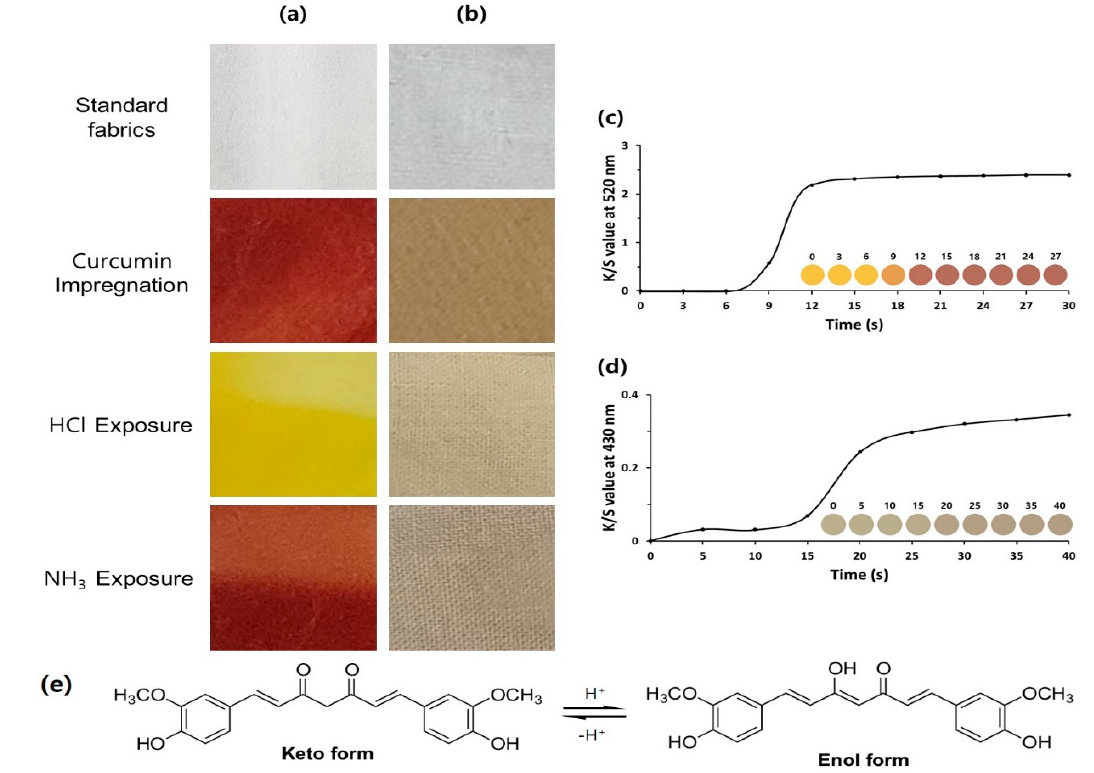
Figure 4. The photographs showing the color changes in ( a ) CECF and ( b ) dyed cotton samples; the traced K/S value as a function of time of ( c ) CECF and ( d ) dyed cotton samples; and ( e ) the scheme for the reaction responsible for the color change.